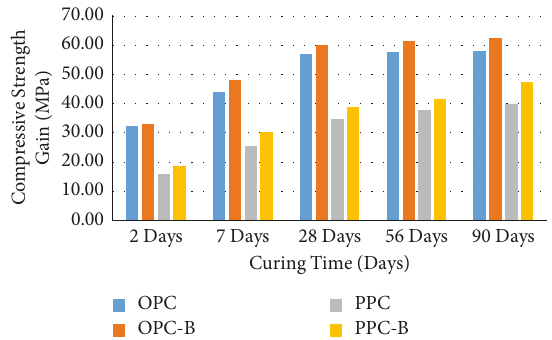
Figure 3: Compressive strength development for OPC and PPC (w/c (cid:30)